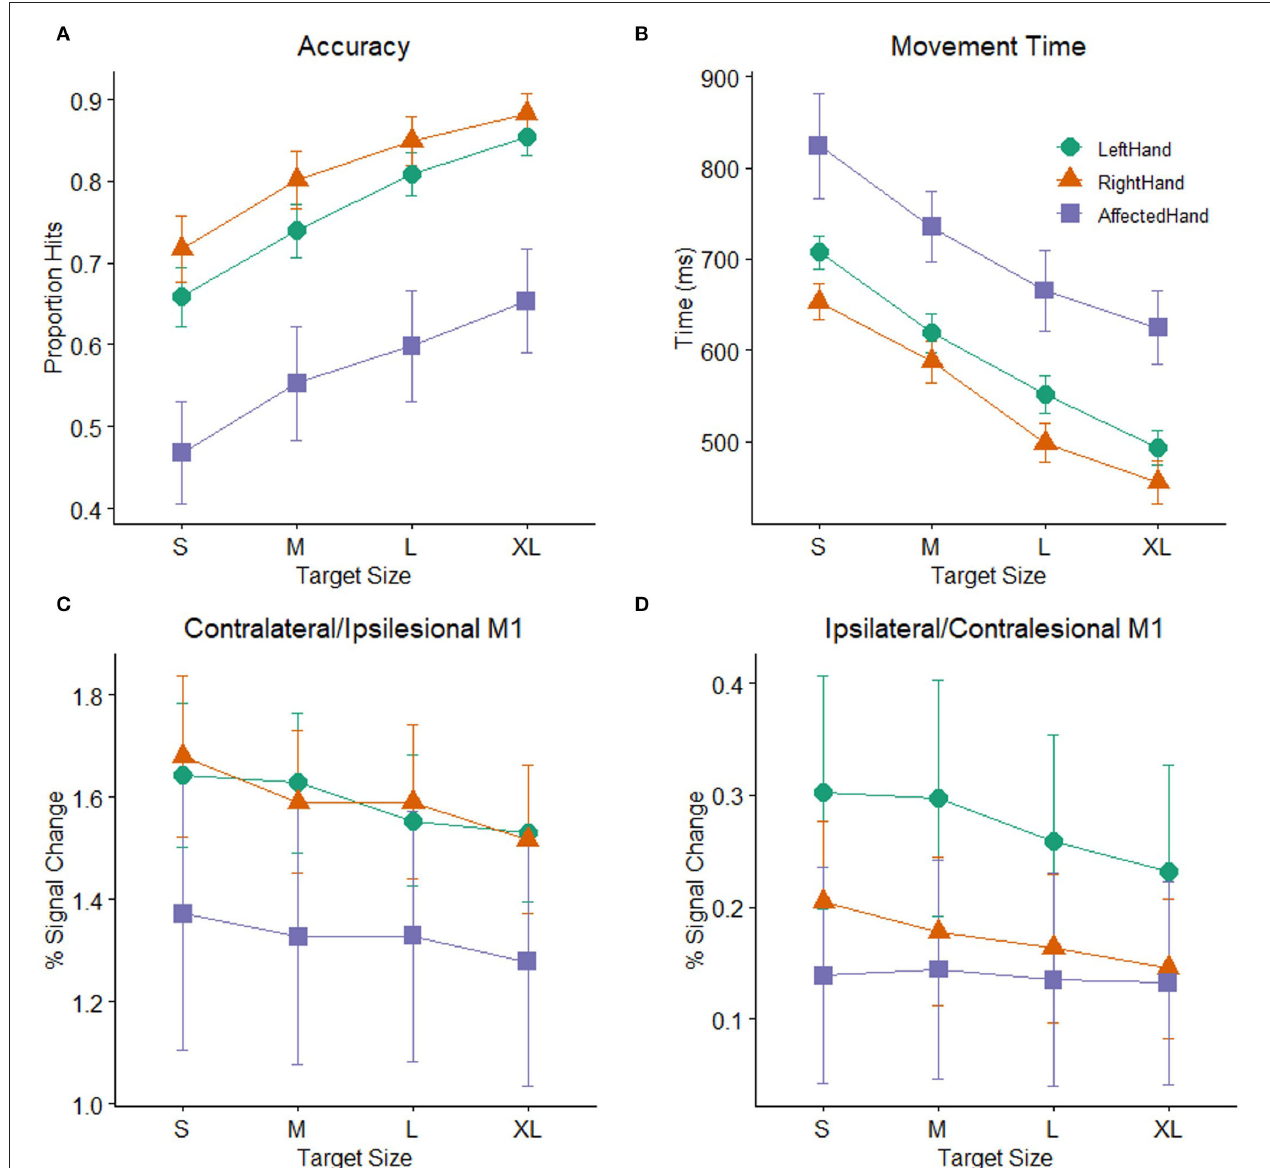
FIGURE 3 | Task performance: (A) Accuracy (proportion hits) for each combination of hand (affected hand in patients with stroke, left hand and right hand in healthy control participants) and target size [small (S), medium (M), large (L), extra-large (XL)] during the hand motor task. Error bars represent SEM. (B) Mean time (in ms) from the onset of the target to when the cursor hit and remained on the target for each combination of hand and target size. Consistent with Fitts’ law, participants showed greater accuracy and faster movement times as the target size increased. (C) BOLD response (percent signal change) during movement to targets of different sizes plotted for the contralateral M1 ROI (healthy controls) or ipsilesional M1 ROI (patients with stroke). (D) BOLD response (percent signal change) during movement to targets of different sizes plotted for the ipsilateral M1 ROI (healthy controls) or contralesional M1 ROI (patients with stroke).